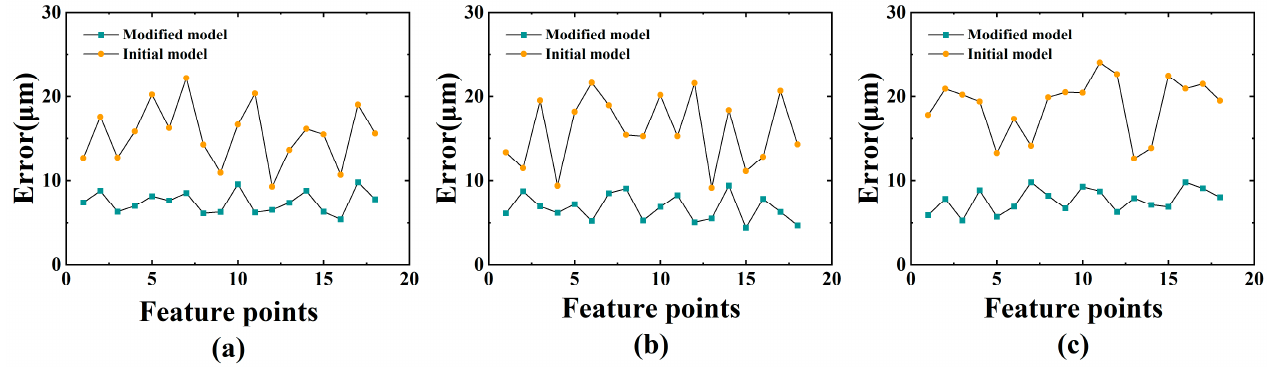
Figure 21. Comparison of calculation errors before and after finite element model correction at feature points ( a ) X-direction ( b ) Y-direction ( c ) Z-direction.